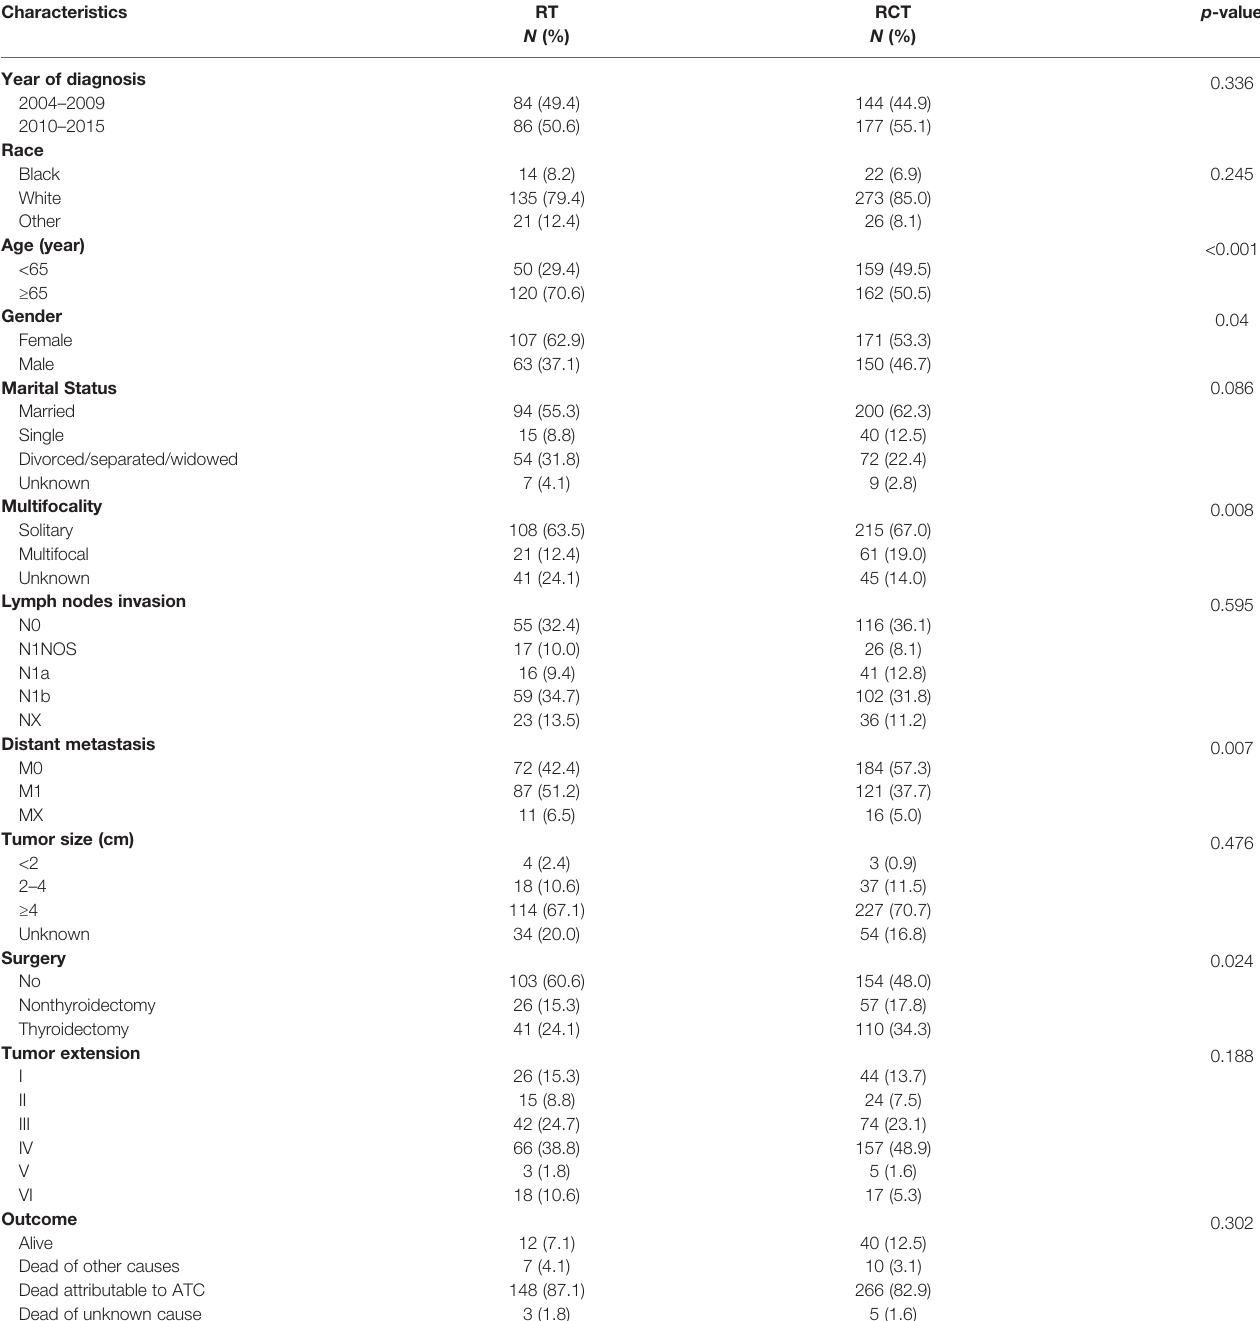
TABLE 1 | Baseline